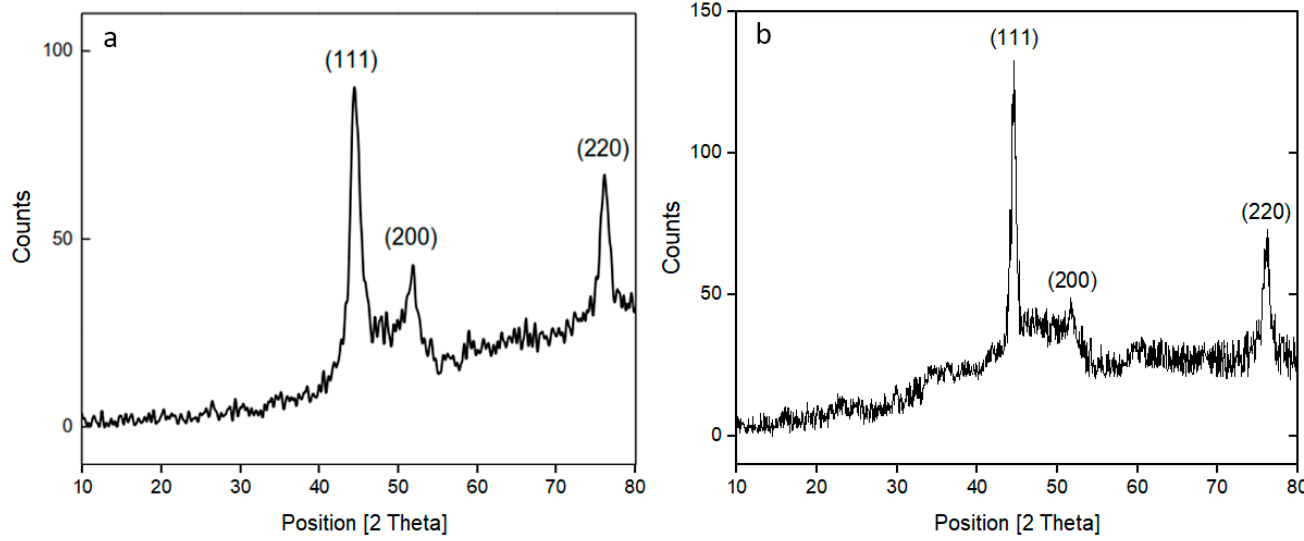
Figure 1. XRD patterns of the synthesized ( a ) CoNiFe, and ( b ) CoNiZn samples.